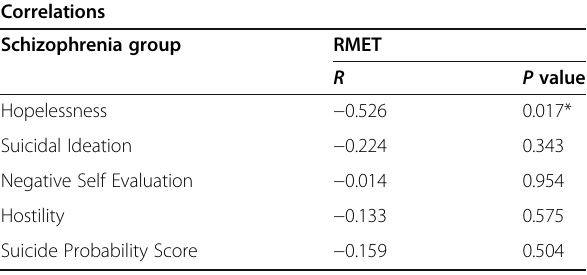
Table 5 Correlation between RMET and suicide probability in the schizophrenia